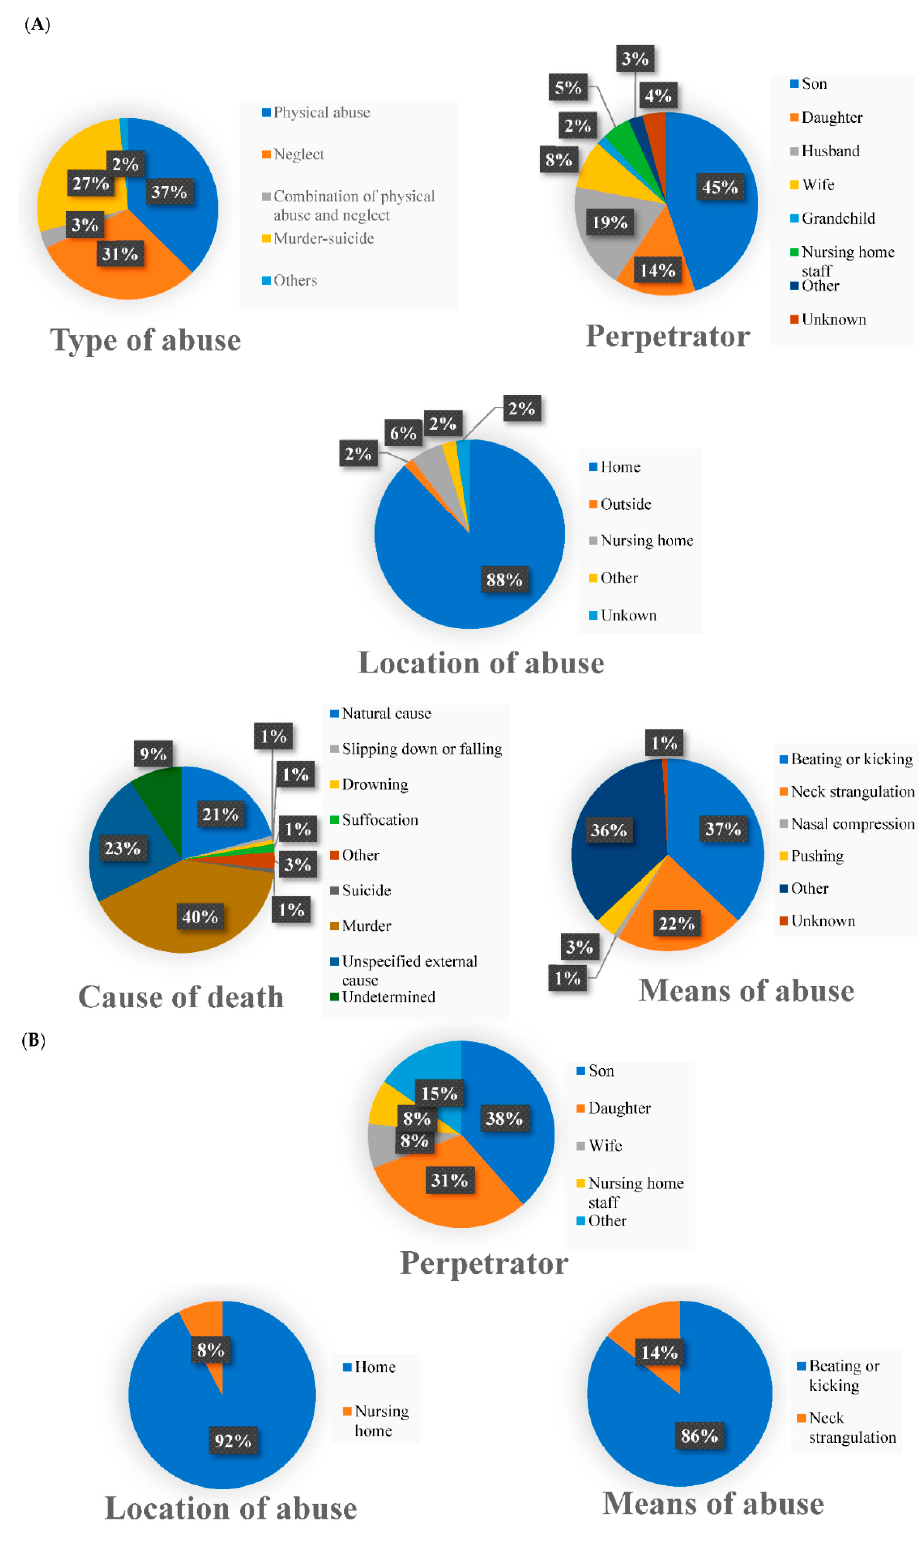
Figure 1. Details of cases of elder abuse reported by forensic medicine departments. ( A ) Autopsy cases; type of abuse, perpetrator, location of abuse, means of abuse, and cause of death. ( B ) Cases of elder abuse other than autopsy cases; perpetrator, location of abuse, and means of abuse.